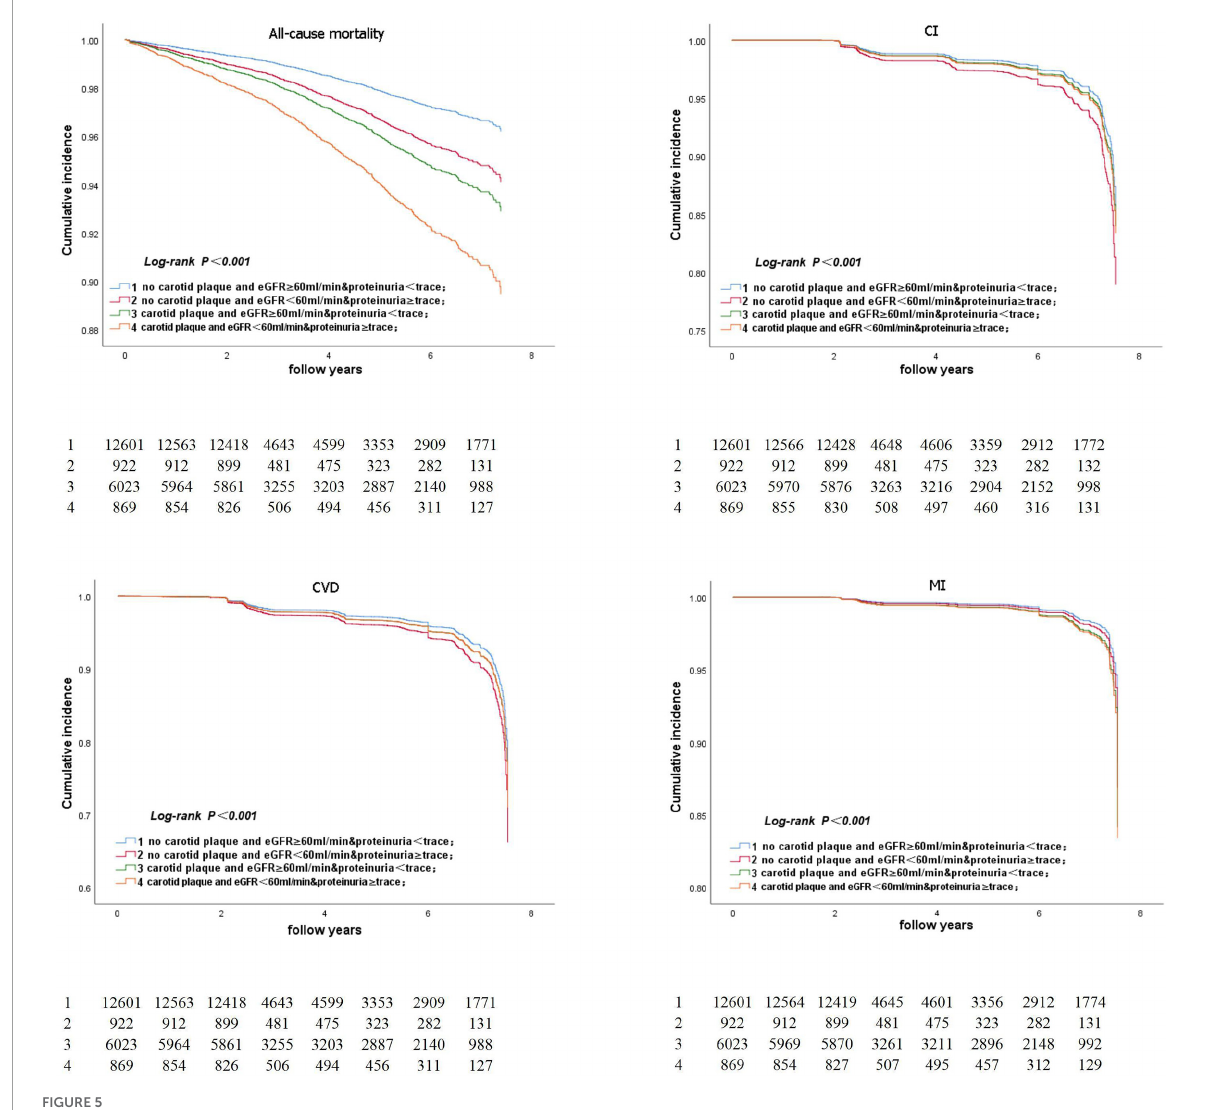
FIGURE5 Kaplan-Meier survival curve for all-cause death and CVD